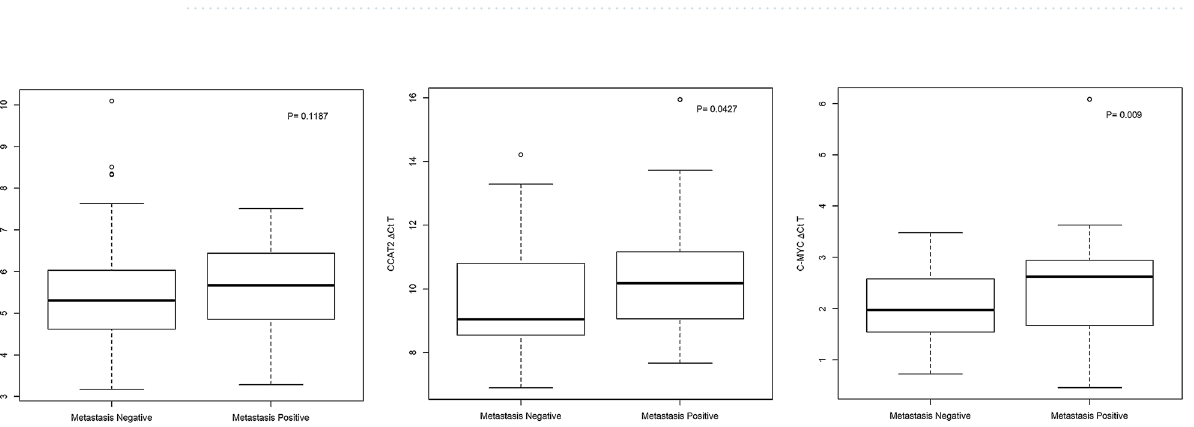
Table 1. Univariable analysis of time to metastasis by Cox regression. Bold is significant ( p < 0.05) value.